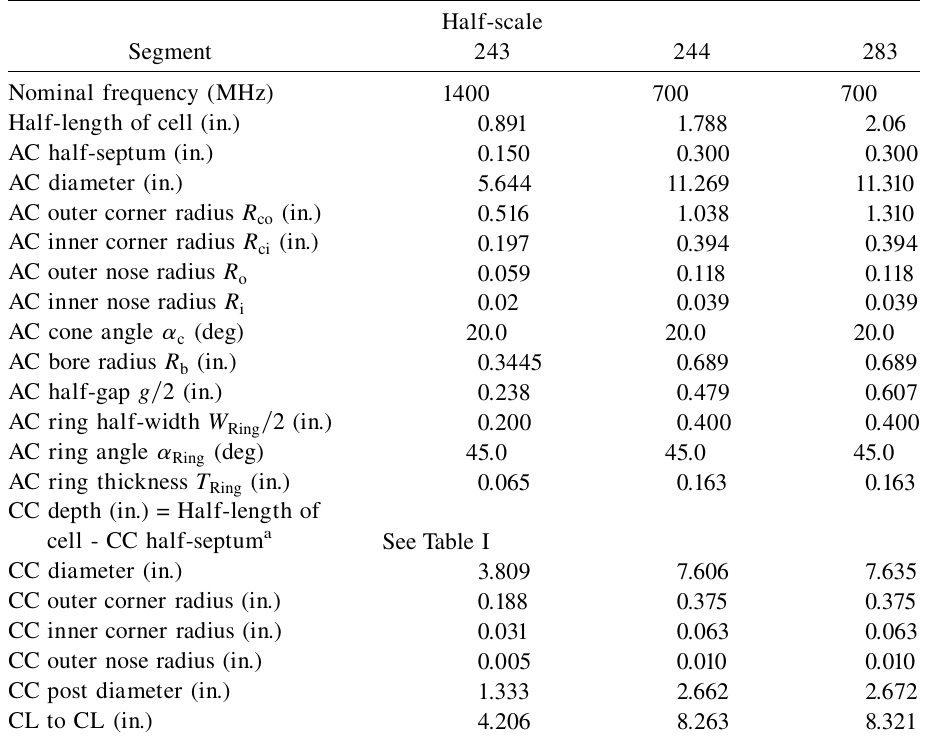
TABLE II. Various dimensions used in test models; see Figs. 3 and 4